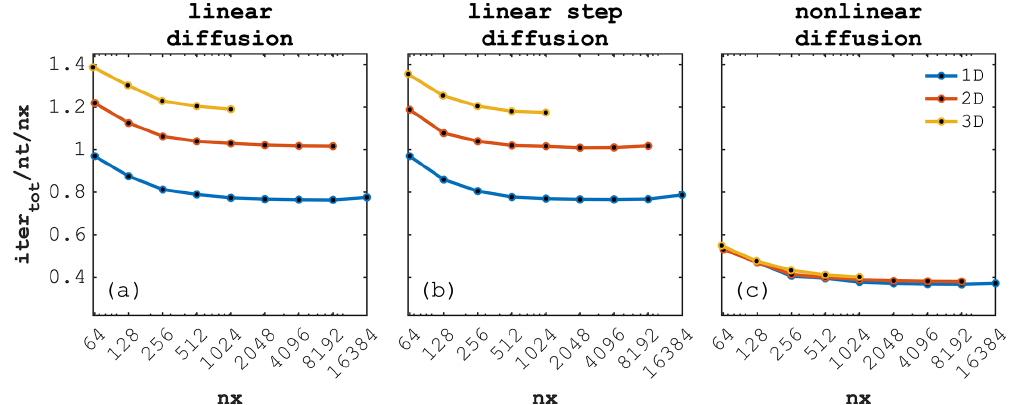
Figure 5. Iteration count scaled by the number of time steps ( n t ) and by the number of grid cells in the x direction ( n x ) as function of n x , comparing 1D, 2D and 3D models for the three different diffusion configurations: (a) linear diffusion, (b) linear step diffusion and (c) nonlinear diffusion,